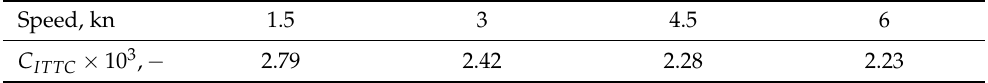
Table 6. Viscous resistance coefficients according to the ITTC correlation line. Speed,